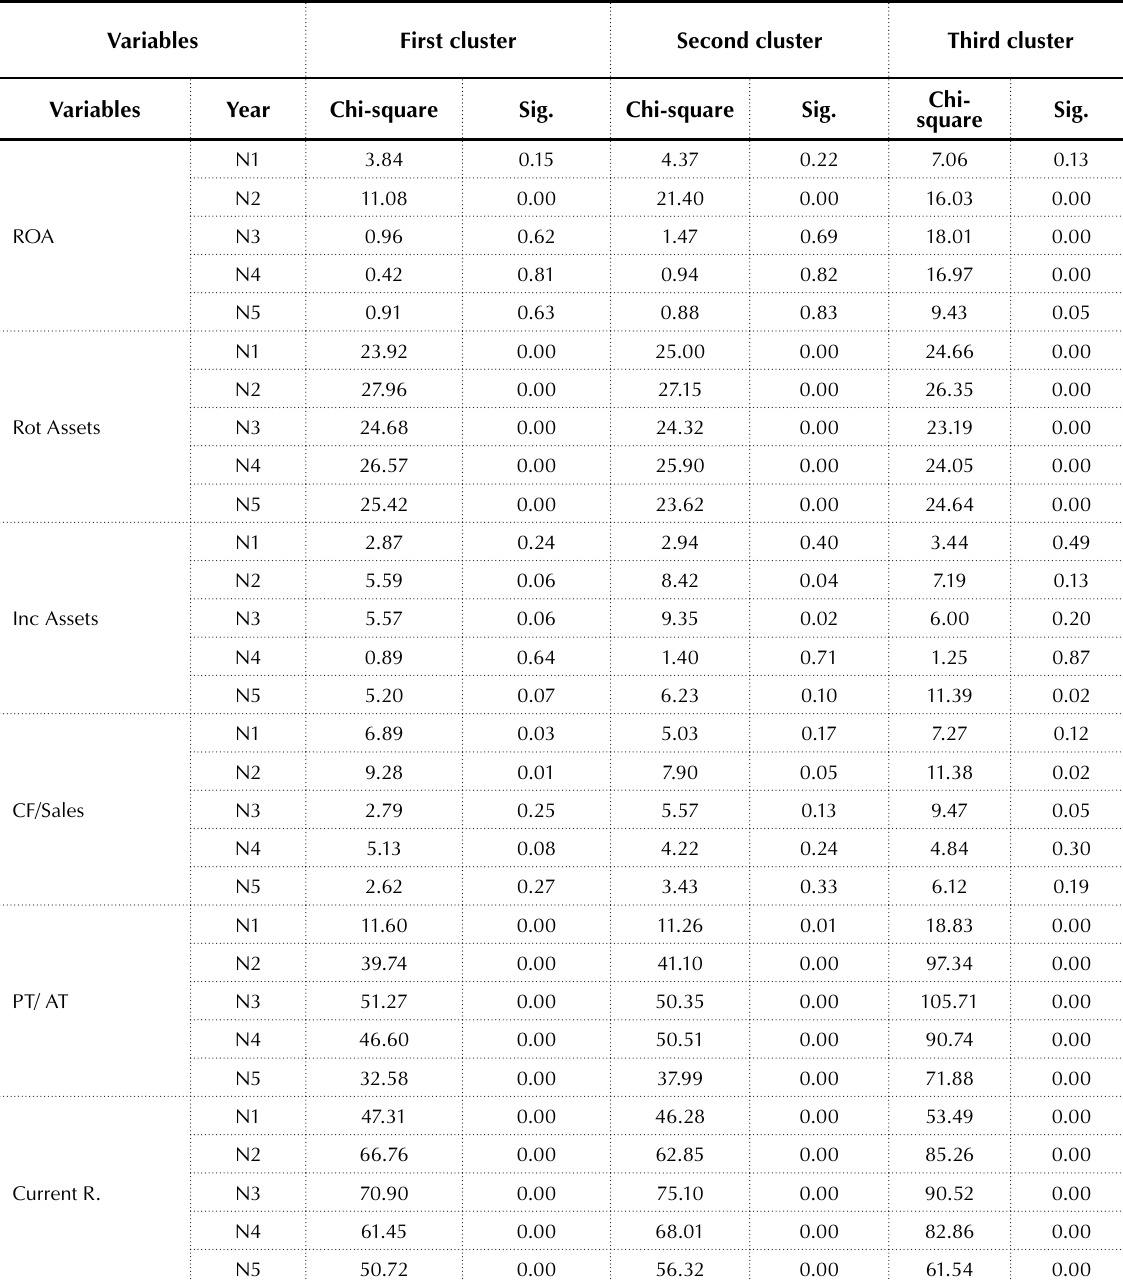
Table 4. Kruskal-Wallis contrast with the ratios described by Laitinen (1991) Variables First cluster Second cluster Third cluster Variables Year Chi-square Sig. Chi-square Sig.